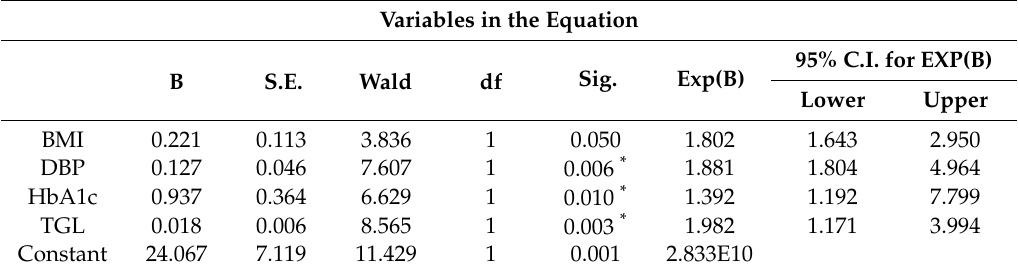
Table 5. Logistic Regression (using Forward Stepwise (Wald) method) considering MTHFR C677T mutation as a dependent